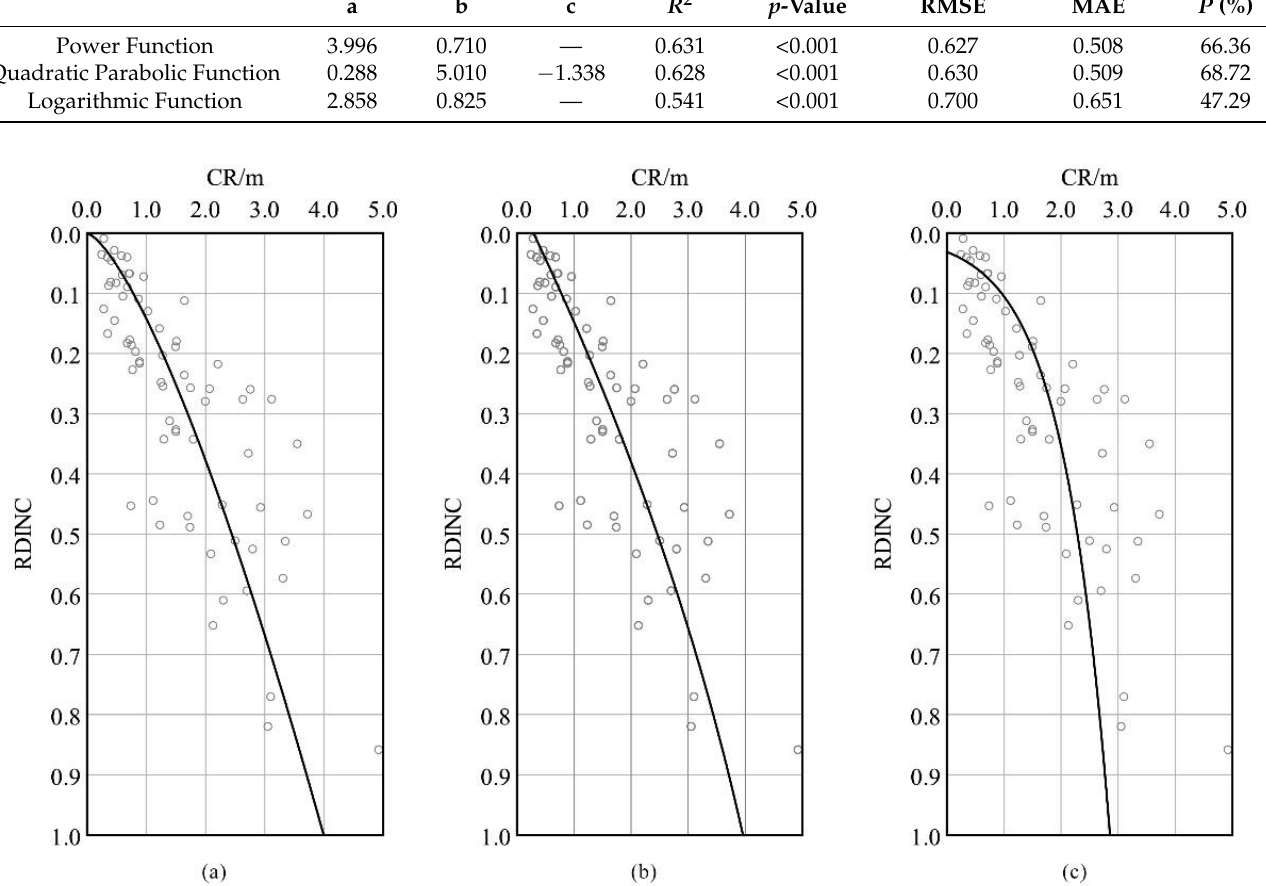
Figure 3. Fitting curves of three CPMs. ( a ) Power function; ( b ) quadratic parabolic function; ( c ) logarithmic function. RDINC is the relative depth into the crown; and CR is the crown radius.